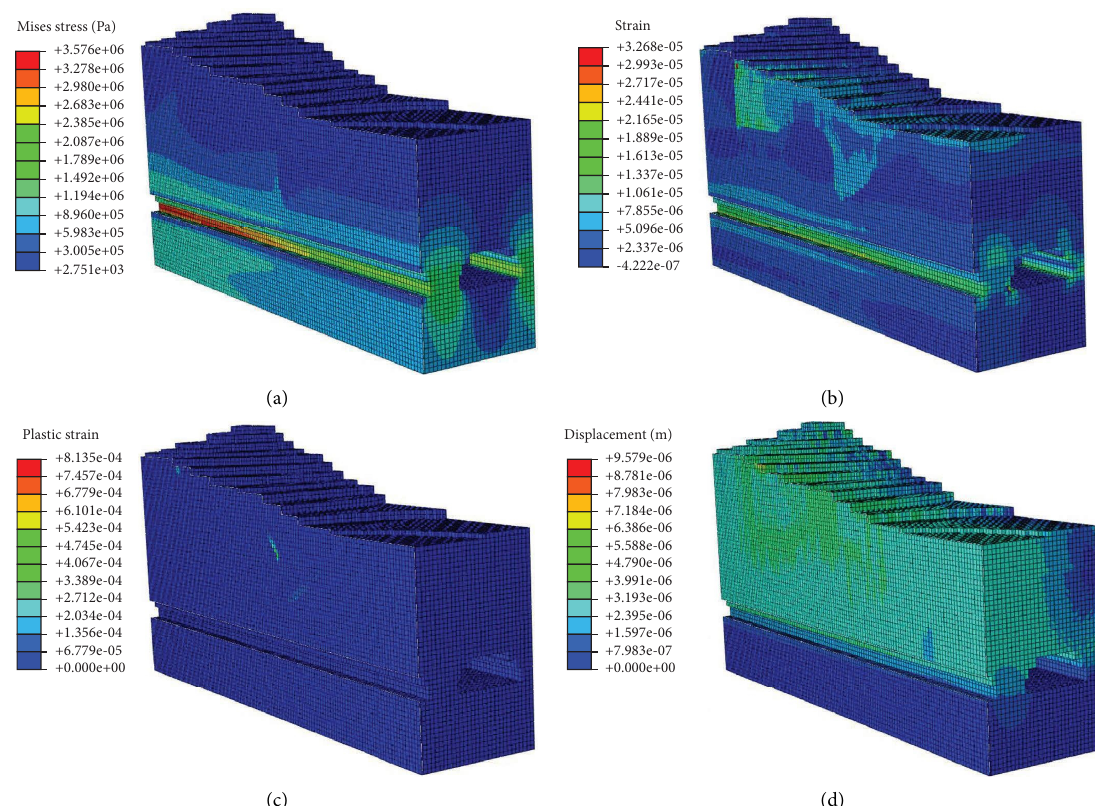
Figure 12: Stress, strain, and displacement of a slope and tunnel under rainfall: (a) Mises stress. (b) Strain. (c) Plastic strain. (d)